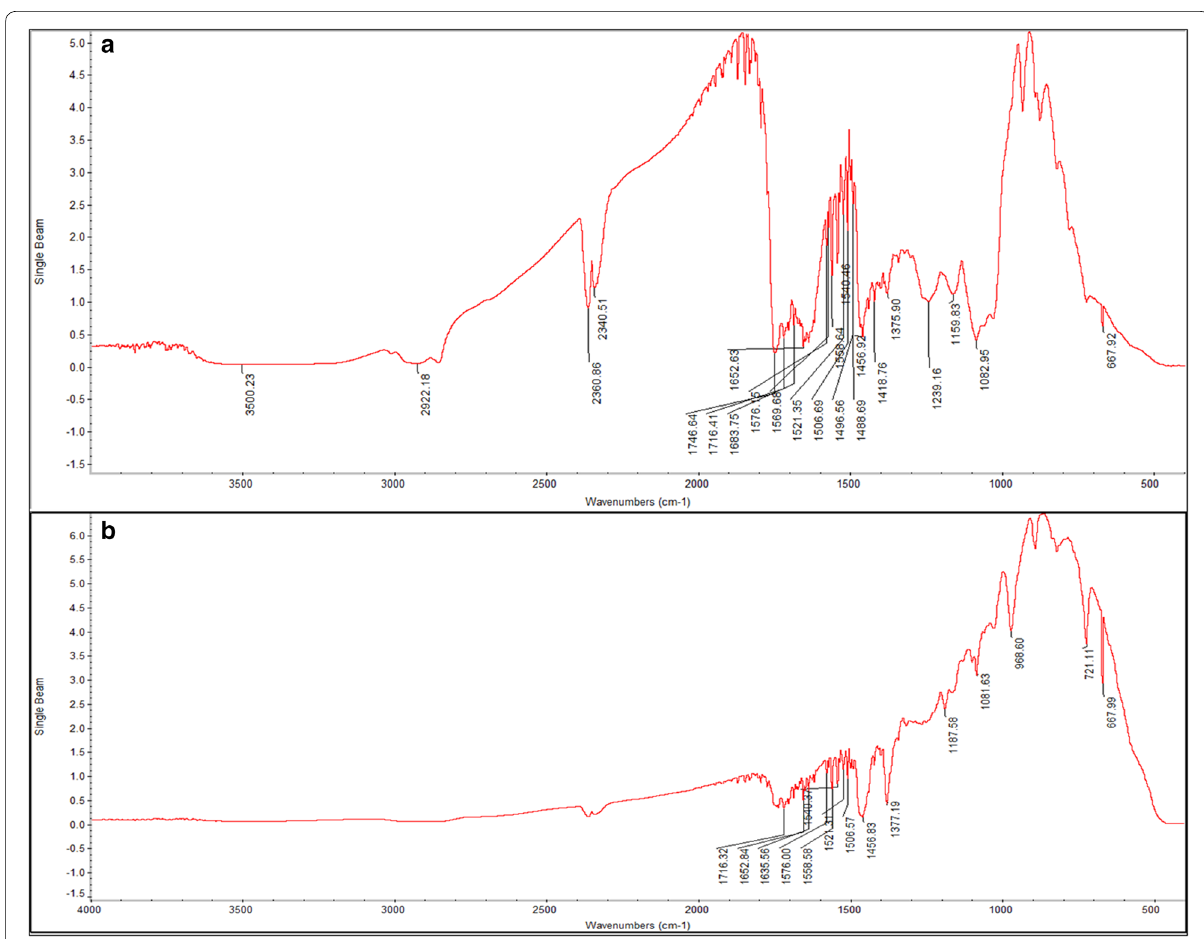
Fig. 2 FTIR analysis of the column fraction of Talaromyces purpureogenus isolate- ABRF2. a Graph represents the FTIR pattern of chloroform fraction of selected sample. b Graph represents the FTIR pattern of ethyl acetate fraction of selected